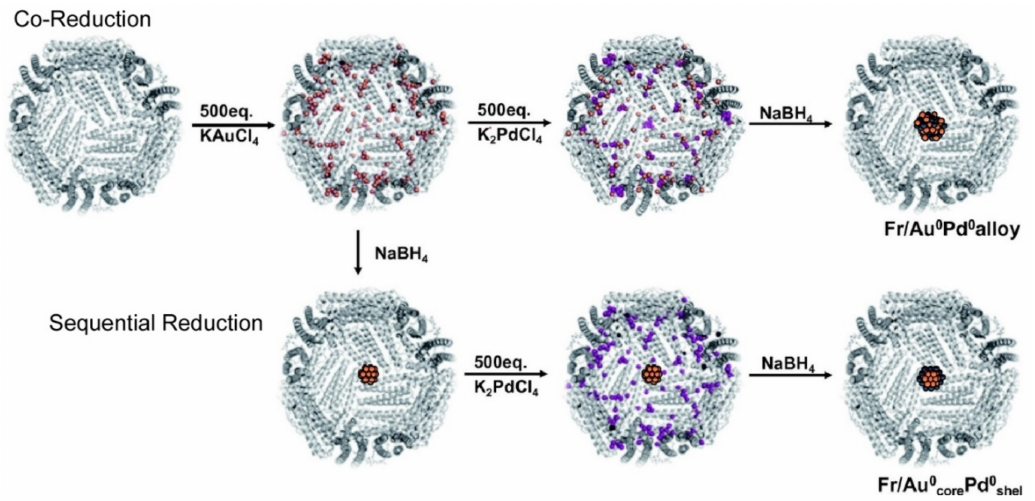
Figure 23. Nanospaces of the apo-ferritin forms used as reaction fields for metallic nanoarchitecton- ics such as preparation of alloy core-shell and bimetallic Au 0 /Pd 0 nanoparticles. Reprinted with permission from Reference [168]. Copyright 2020 Chemical Society of